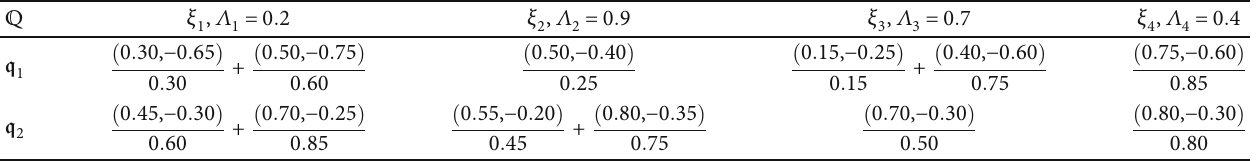
Table 1: Tabular representation of Γ = ð τ , H , Λ : Þ